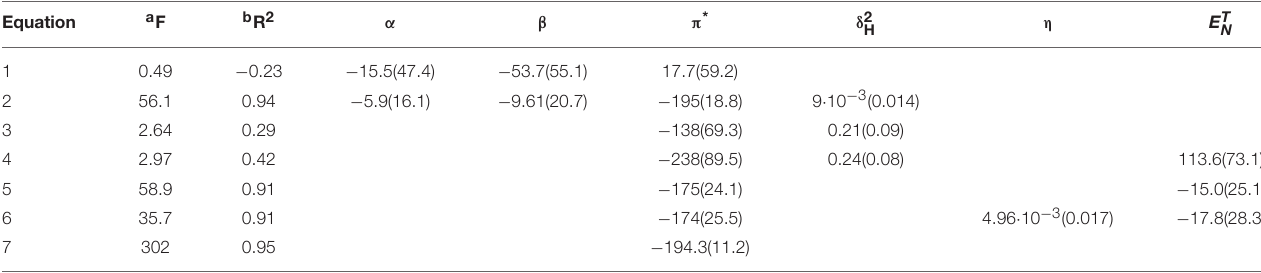
a Statistical F. b Correlation coefficient. Standard deviations are given in